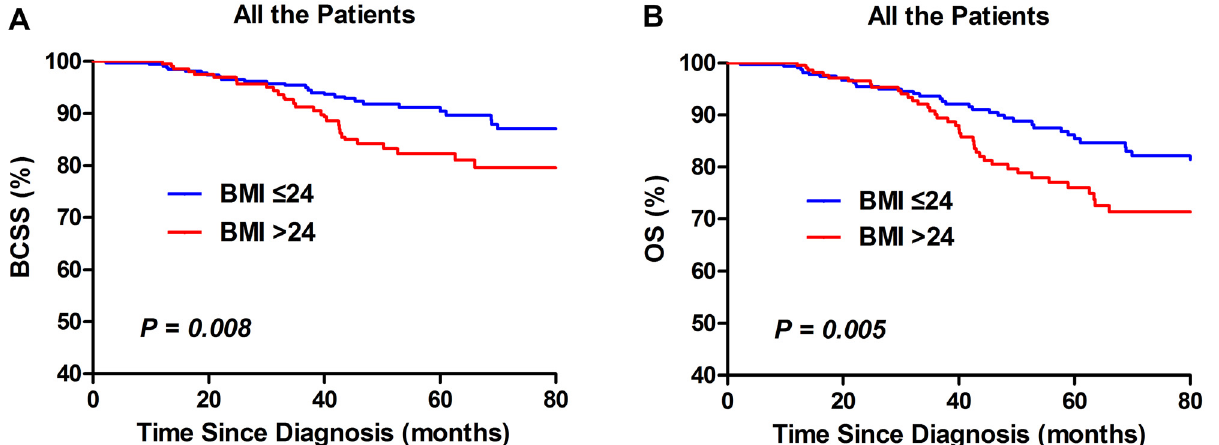
Table 3) or OS (HR: 1.07, 95% CI: 0.70 – 1.64, P = 0.754;Table 4). By using the Schoenfeld resid- uals, there was no evidence that the effect of BMI on survival outcome changed with date of diagnosis ( P = 0.928) in the test of proportional hazards assumption.